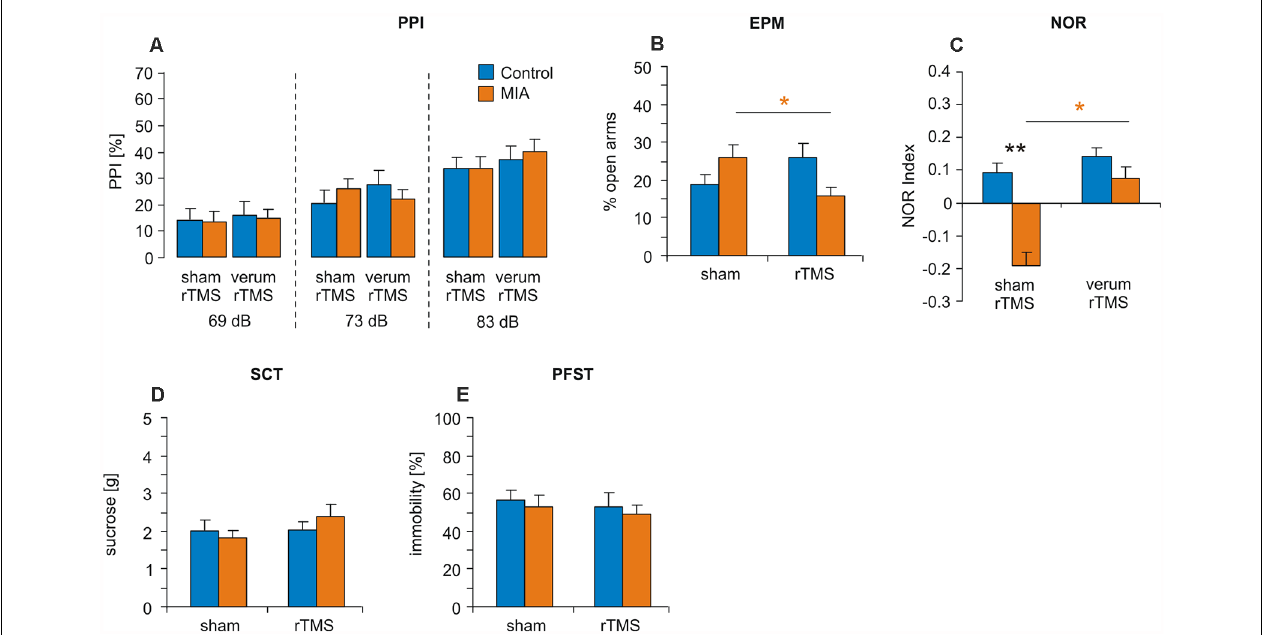
FIGURE 3 | iTBS applied to juvenile rats: effects on PPI, EPM, NOR, SCT and PFST. MIA and control rats were tested at adulthood for (A) PPI, (B) EPM, (C) NOR, (D) SCT and (E) PFST after iTBS-rTMS (sham or verum) had been applied during adolescence. Colored asterisks: t -test comparing sham and verum-iTBS groups (controls: blue, MIA: orange), black asterisks: t -test comparing MIA and control groups. * p < 0.05, ** p < 0.01. Data are shown as group means ± SEM. N = 12 control-sham, N = 12 control-verum, N = 13 MIA-sham, N = 14